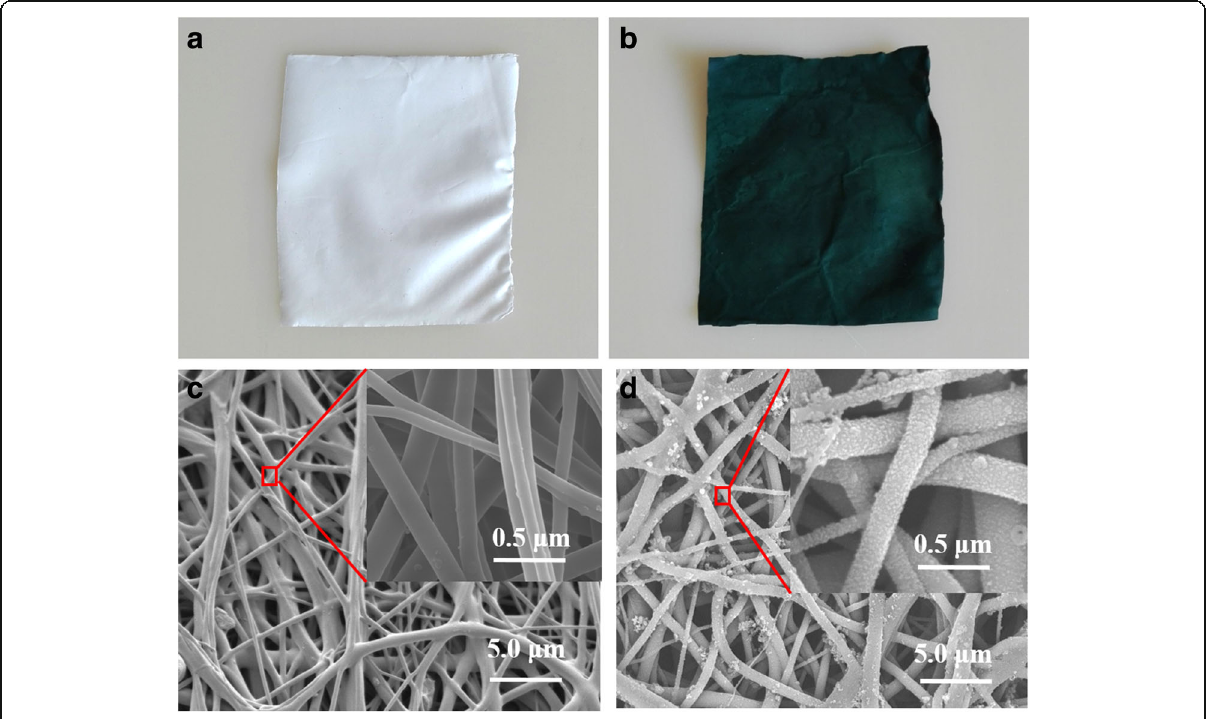
Fig. 2 Morphology and structure of TPU and PANI/TPU membrane. a , b Optical images of pure TPU nanofibrous membrane and PANI/TPU nanofibrous membrane. c , d SEM images of pure TPU nanofibrous membrane and PANI/TPU nanofibrous